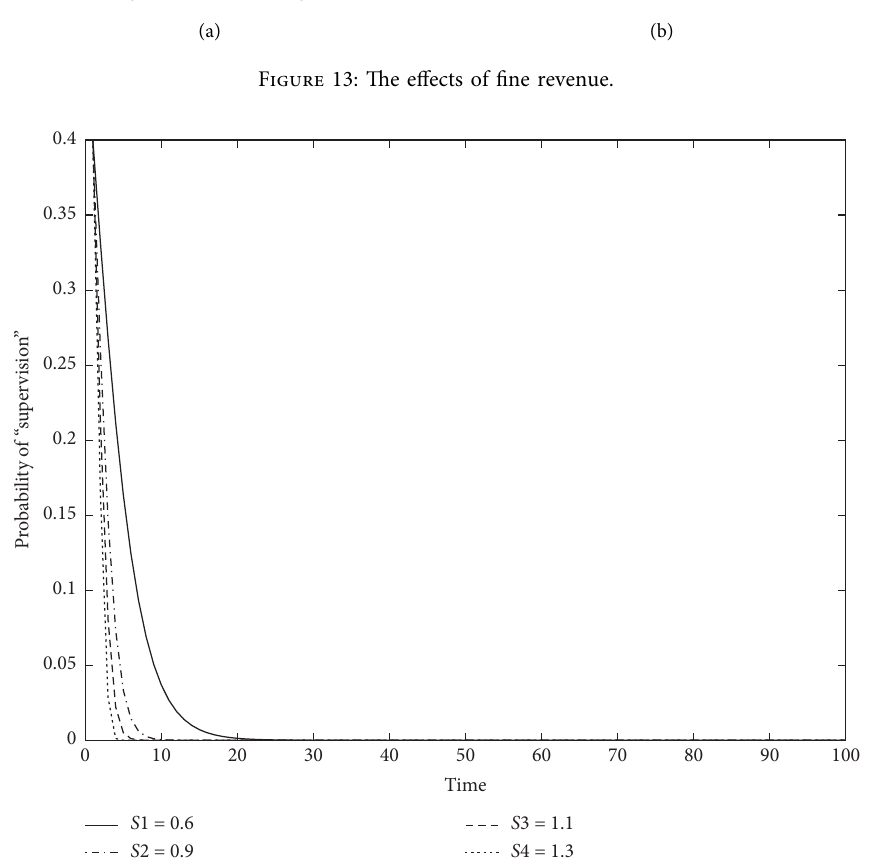
Figure 14: The effects of supervision